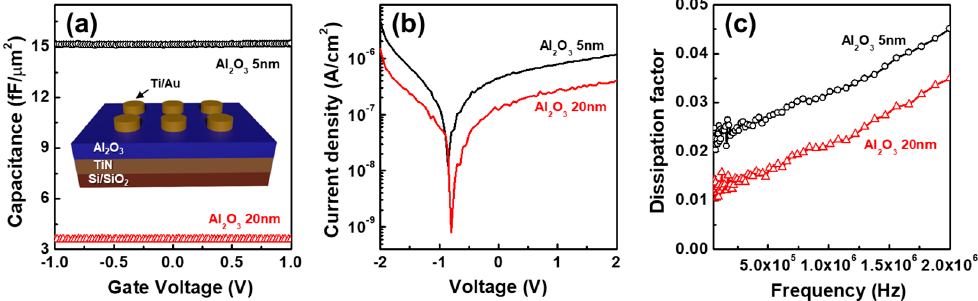
Figure 6. ( a ) High–frequency (1 MHz) capacitance–voltage (C–V) curves, ( b ) leakage current density, and ( c ) dissipation factor as a function of frequency for MIM devices with various Al 2 O 3 thickness. The inset of ( a ) shows the schematic of MIM structure.